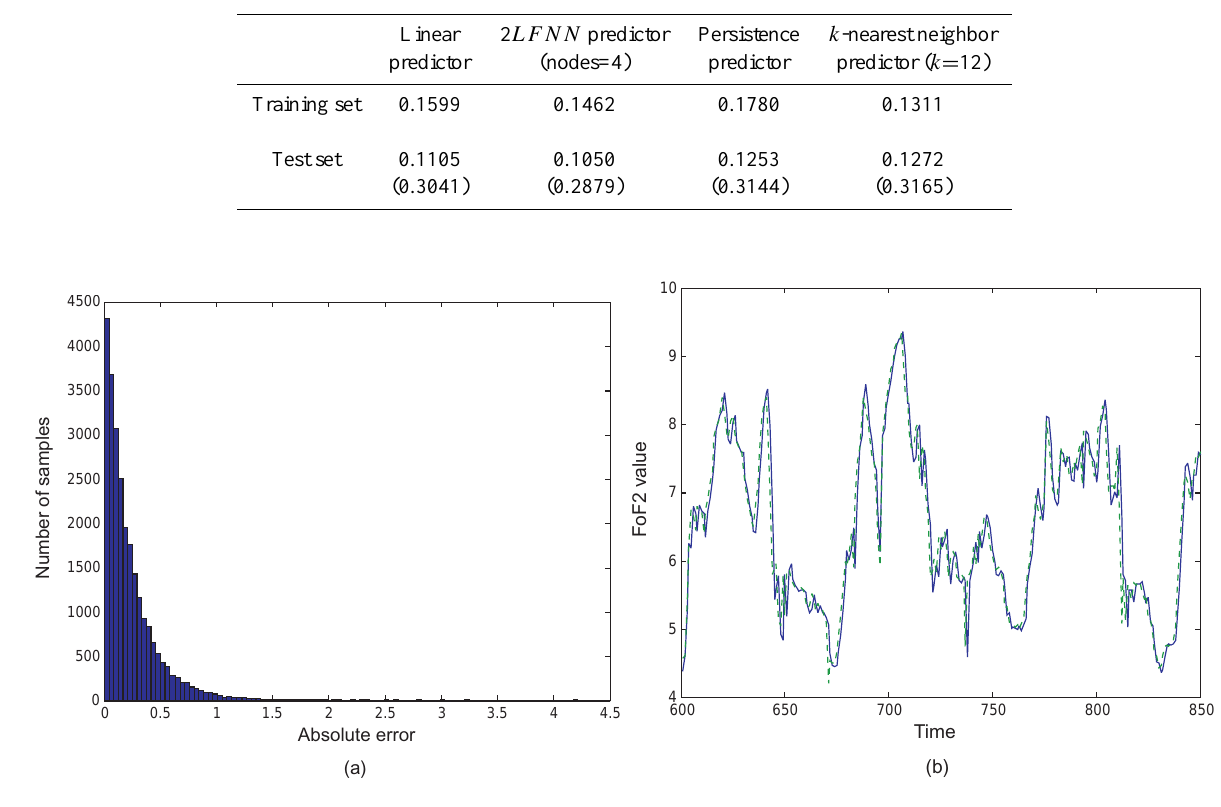
Fig. 2. One-step ahead (15min) prediction, with the linear predictor. (a) The histogram of the absolute differences of the computed and the actual outputs, for the test set. (b) The actual (solid line) and the computed (dotted line) outputs for a short time interval of the test set.